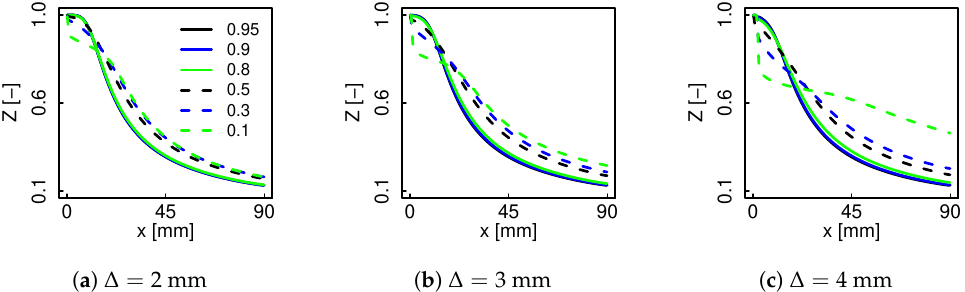
Figure 10. Effect of ct variation, assessed on the Z centerline profiles for three different filter